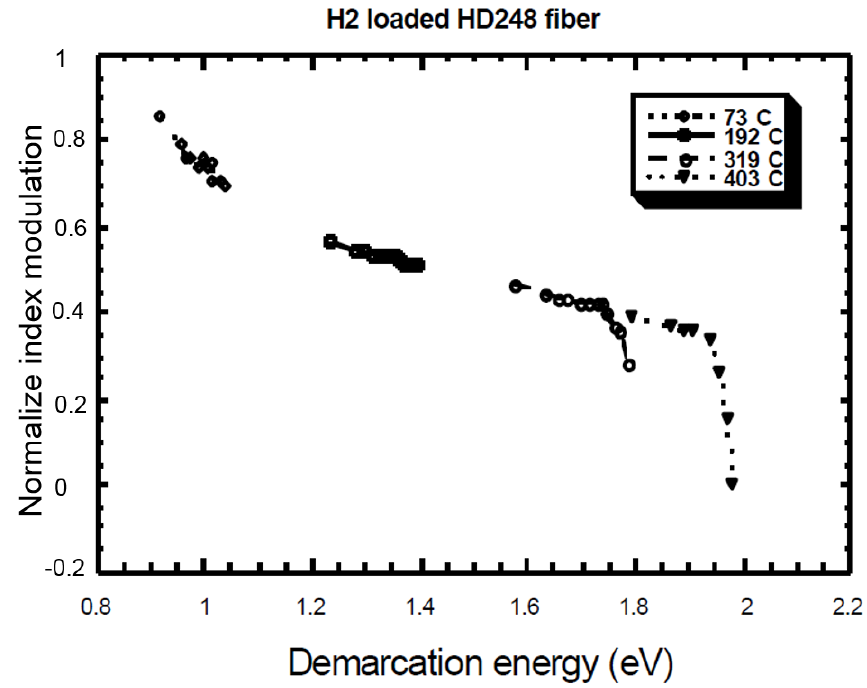
Figure 40. Result from [40]. Copyright 2000 University Lille 1. NICC vs. the demarcation